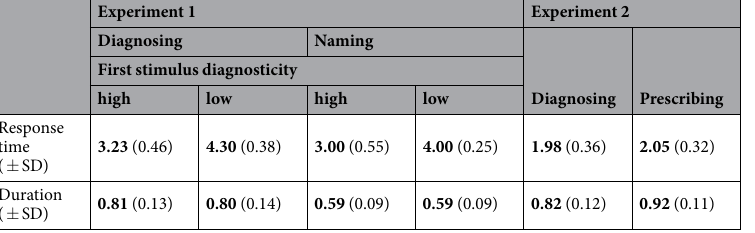
Table 1. Mean response times and durations of the response vocalization in seconds * . * Errors, hesitations, more than one response, and outliers were excluded. Abbreviation: SD, standard